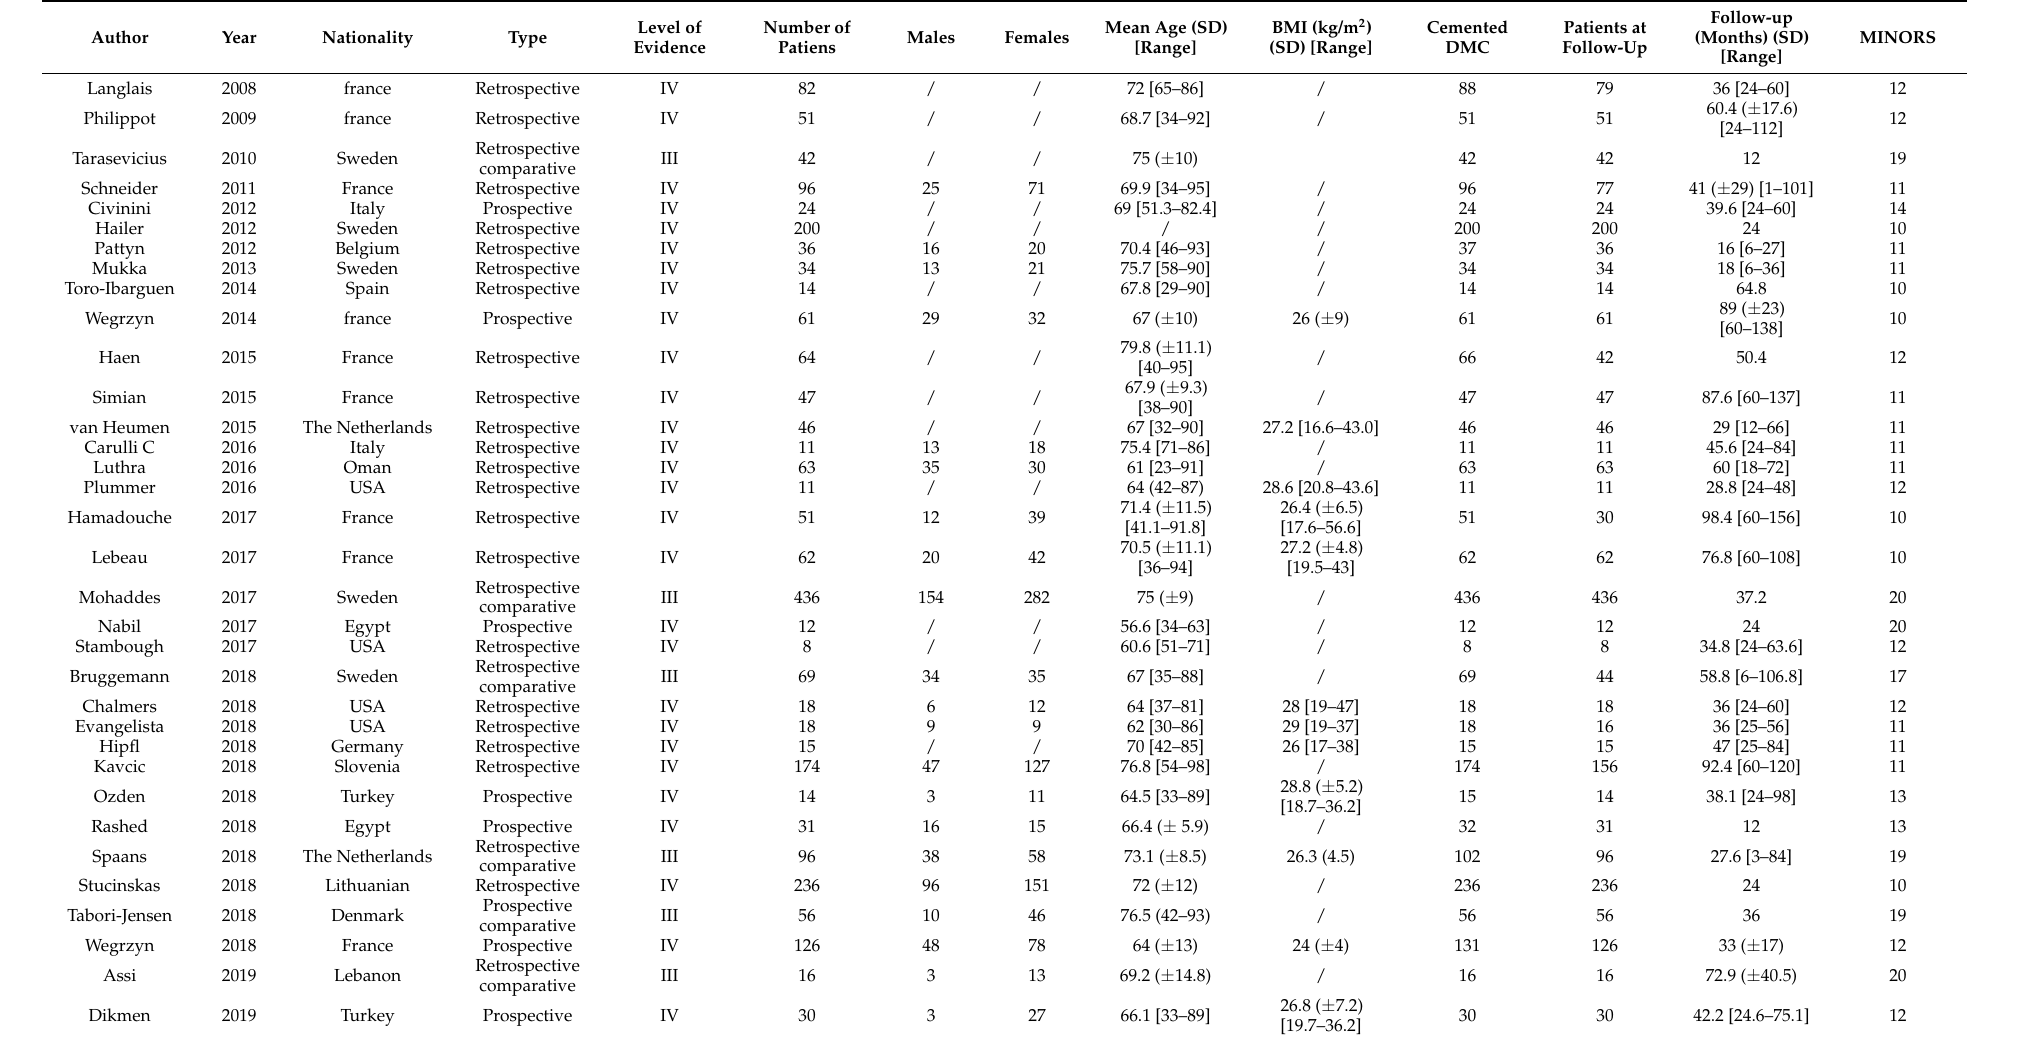
Table 1. Characteristics of studies included in the